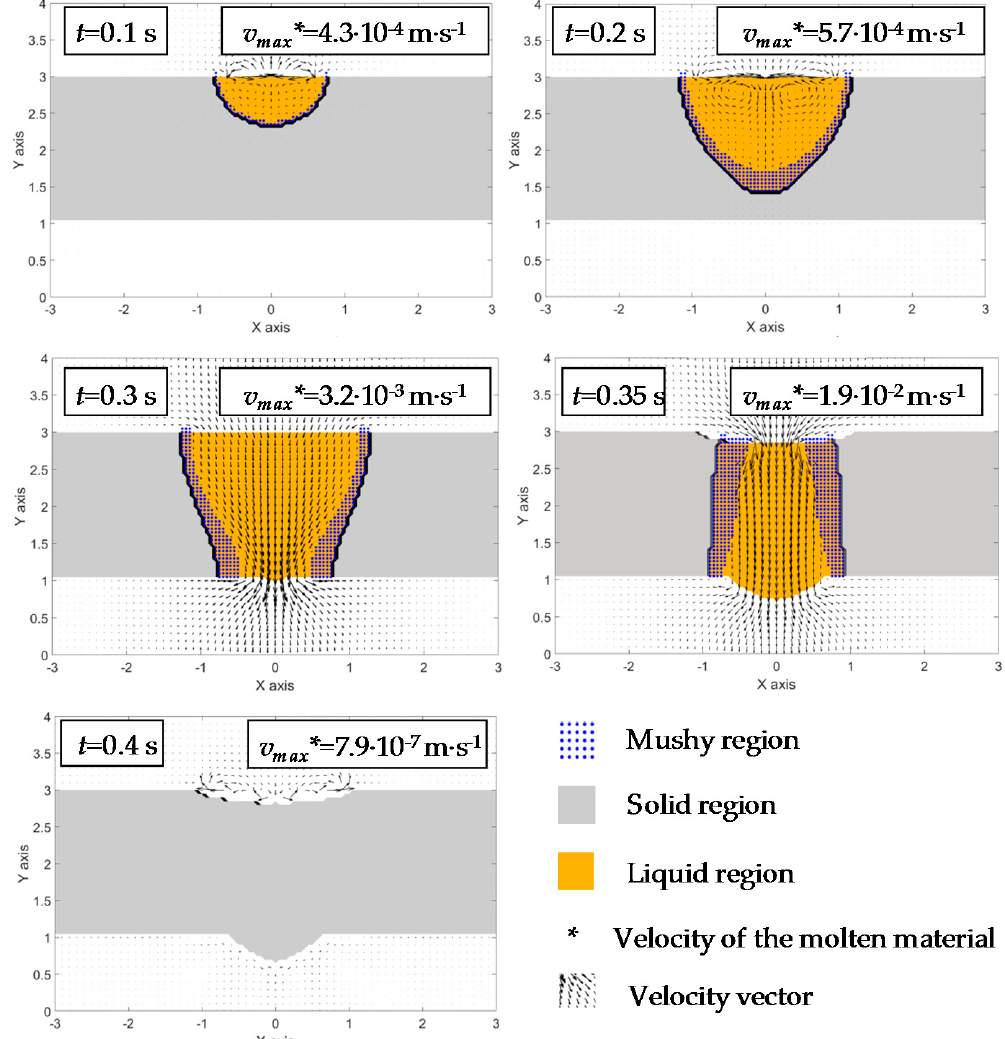
Figure 9. Evolution of the welding section and material velocity for different time steps as the laser beam passes in Test 5.